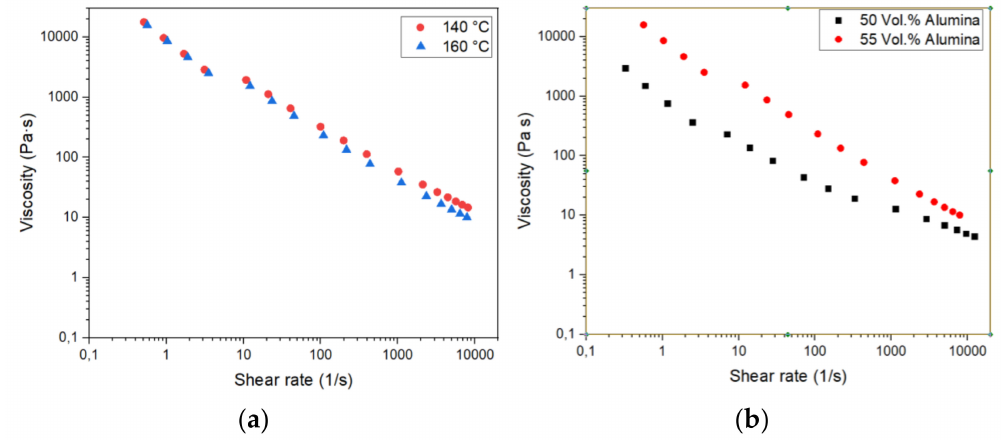
Figure 3. Rheological investigation on the alumina containing feedstocks: ( a ) Viscosity at two di ff erent temperatures (load: 55 vol.%) and ( b ) Two di ff erent solid loadings (temperature: 160 ◦